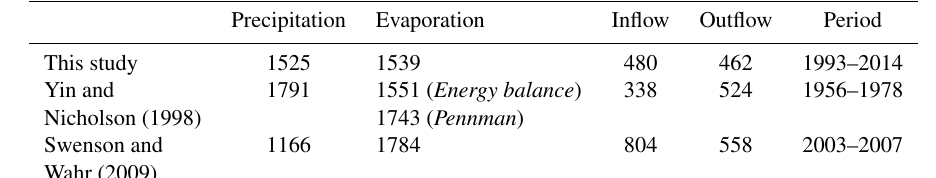
Table 1. Calculated mean annual water balance (WB) terms and values found in literature in mmyr − 1 (inflow and outflow are given in mmyr − 1 over the lake surface area).